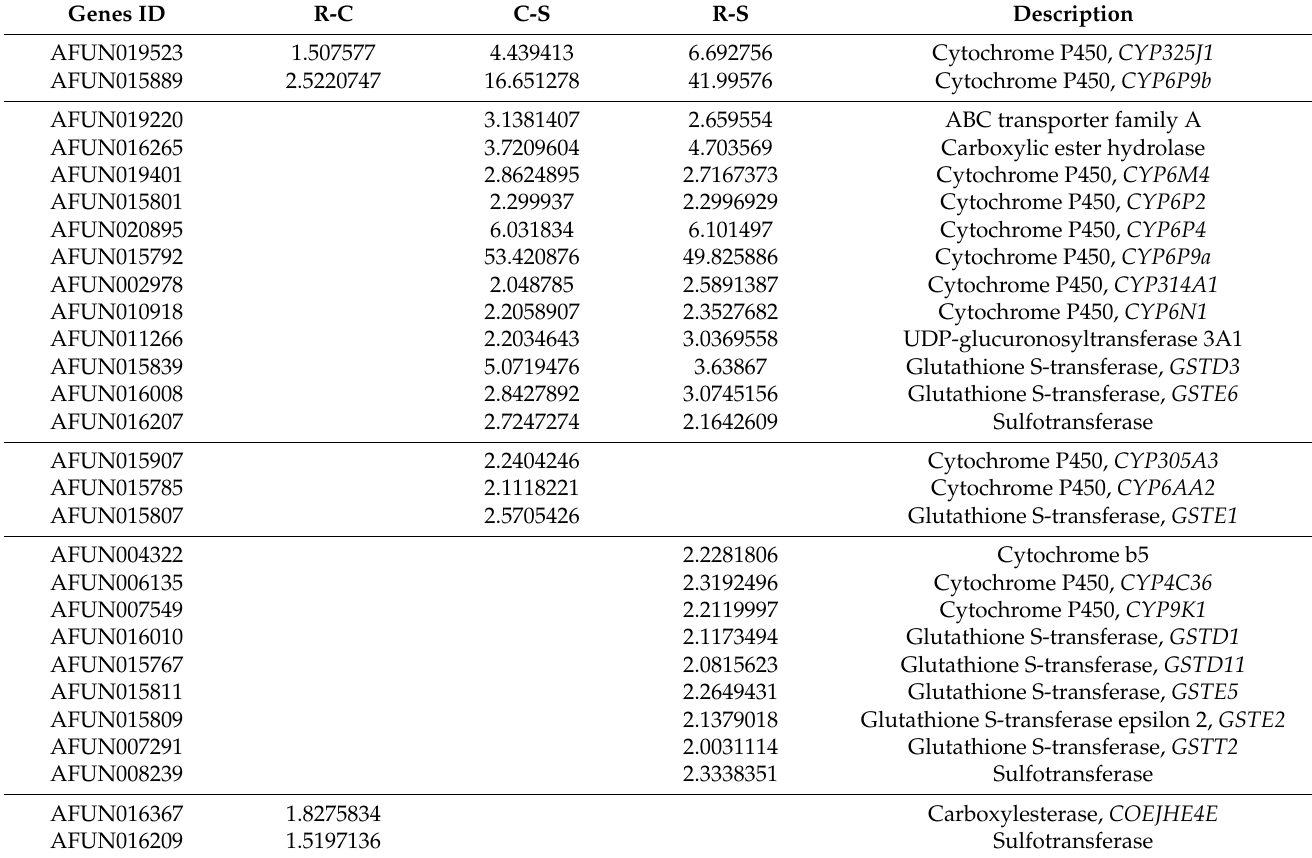
Table 3. Detoxification genes differentially expressed in Malawi between different comparisons at FDR < 0.05 and FC > 1.5 for R-C or FC > 2 for C-S and